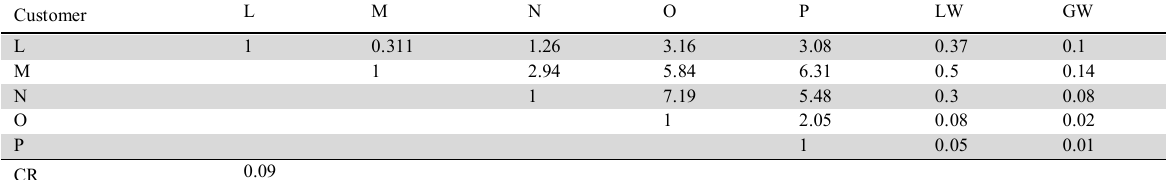
Relative importance normalized local, global weights and consistency ratios of the customer perspective indicators .